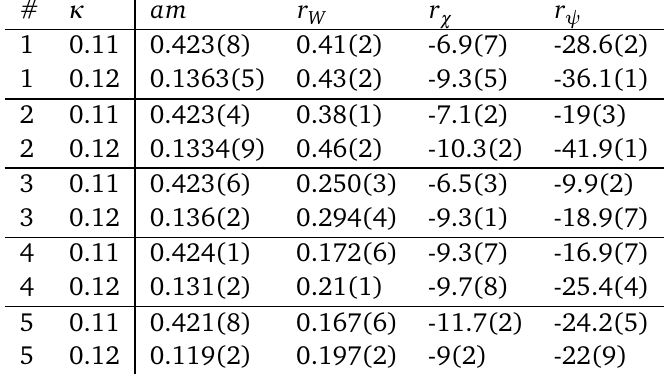
Table 4: Fit parameters for M ψ/χ according to the one-loop motivated fit form (28- 29). Note that the fit is done in the lattice Yukawa coupling Y and not the continuum y